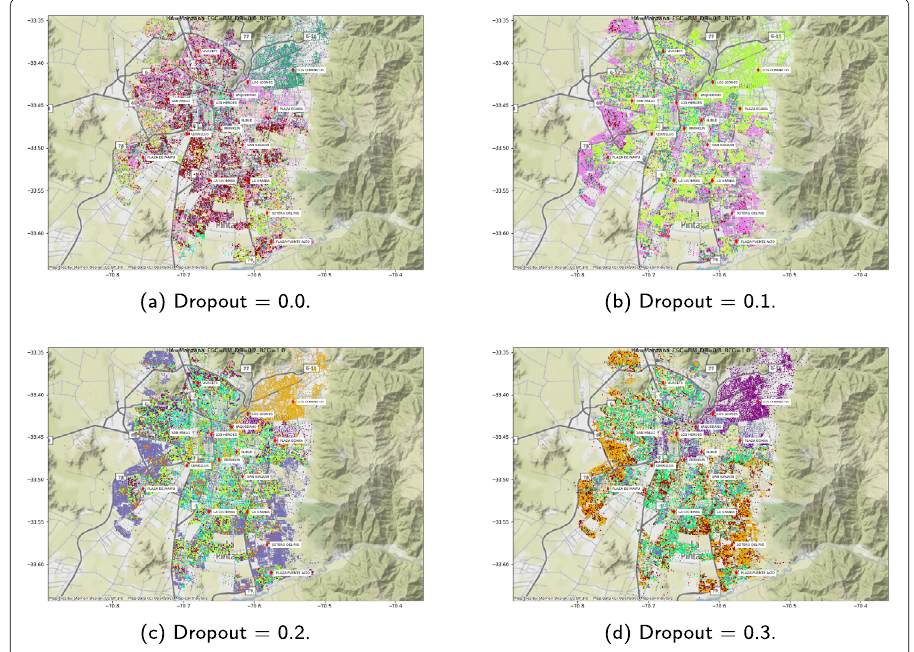
Figure 4 Dropout calibration. Low dropout values (0.0 or 0.1) do not allow distinguishing the local structures of the clusters, mixing them throughout various areas of the region. However, as the dropout increases to